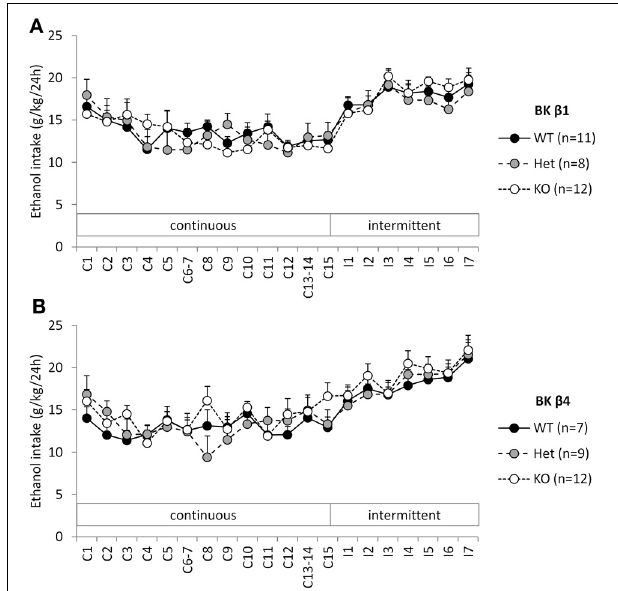
FIGURE 1 | Experiment 1: Ethanol intake under continuous and intermittent access. Individually-housed BK β 1 (A) and BK β 4 (B) WT, Het, and KO mice were first offered continuous access to ethanol (20% w:v) and water in their home cages for 2 weeks (C1–C15). Access was then switched to intermittent (24-h periods, 3 days a week, I1–I7). Number of mice in each group is indicated in the legend.